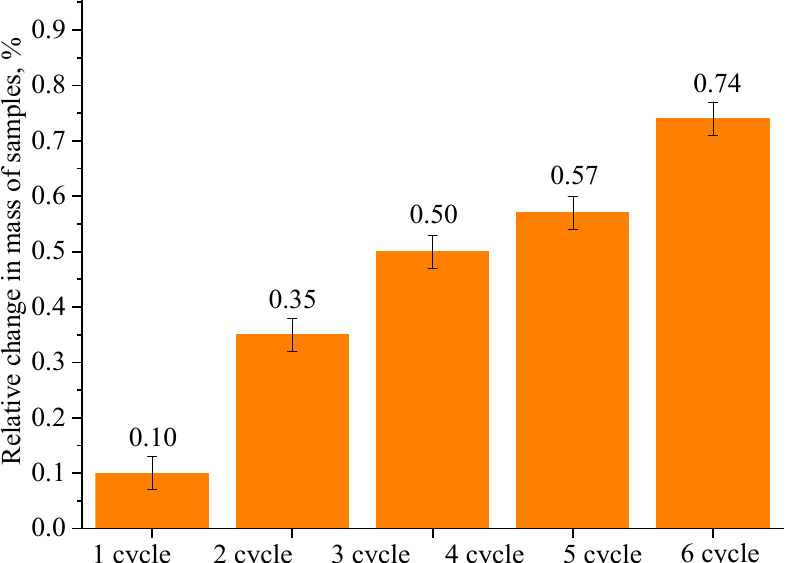
Figure 8. Relative change in the mass of ABE wire samples treated with a hydrophobic coating by sequential immersion method.